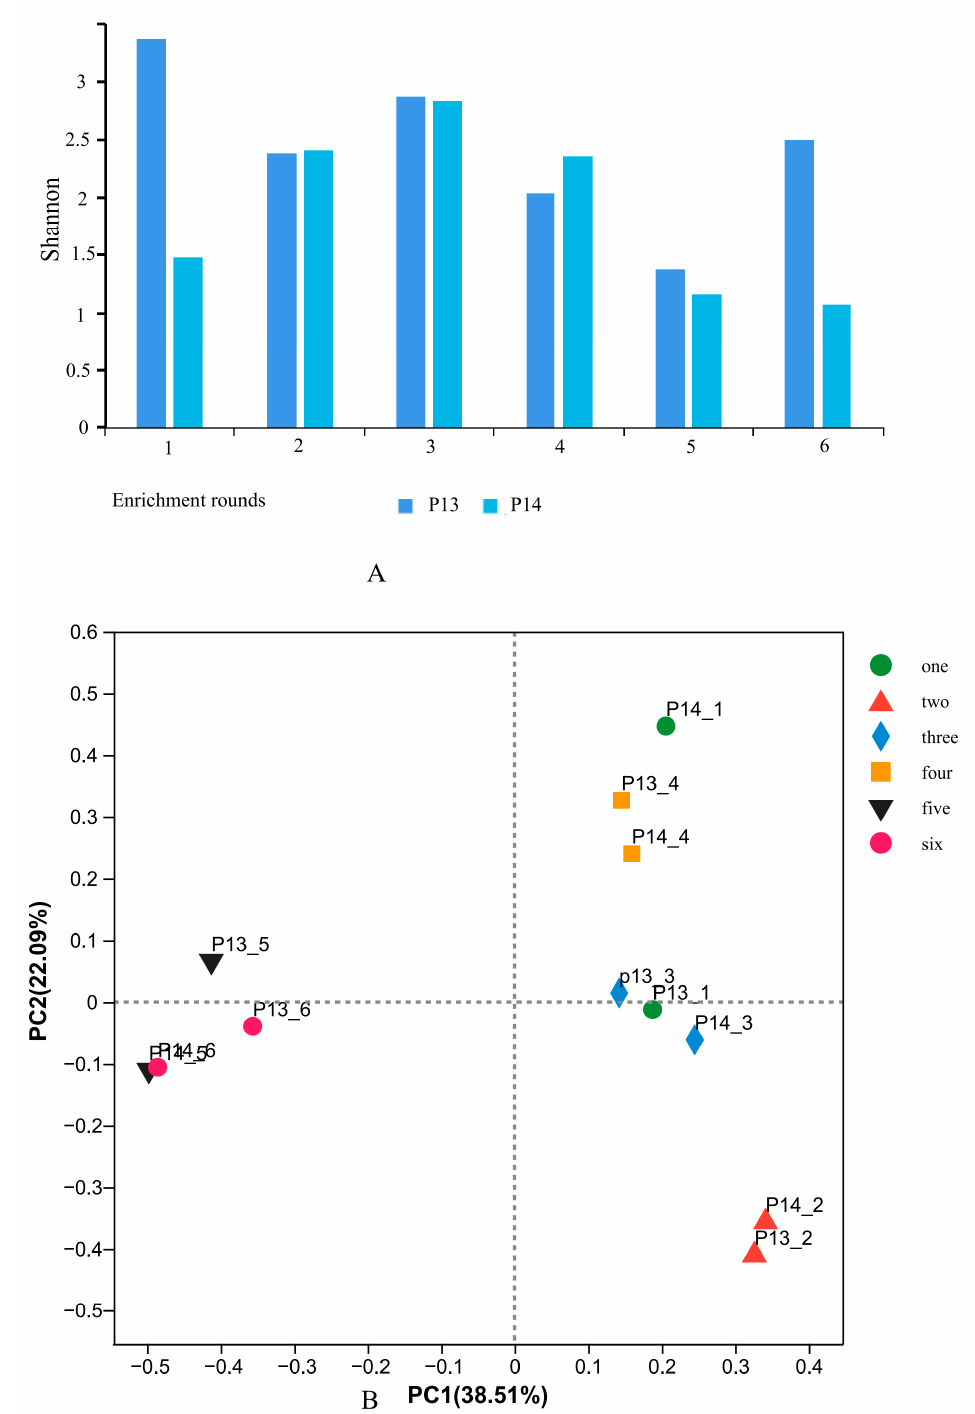
Figure 2. Microbial community diversities of EFB samples in di ff erent enrichment rounds. ( A ) Microbial community diversities of EFB samples in different enrichment rounds. Changes in Shannon diversity indexes of microorganisms in di ff erent enrichment cycles. ( B ) Princi- ( A ) Changes in Shannon diversity indexes of microorganisms in different enrichment cycles. pal coordinates analysis (PCoA) of microbial communities in di ff erent enrichment stages. ( B ) Principal coordinates analysis (PCoA) of microbial communities in different enrichment